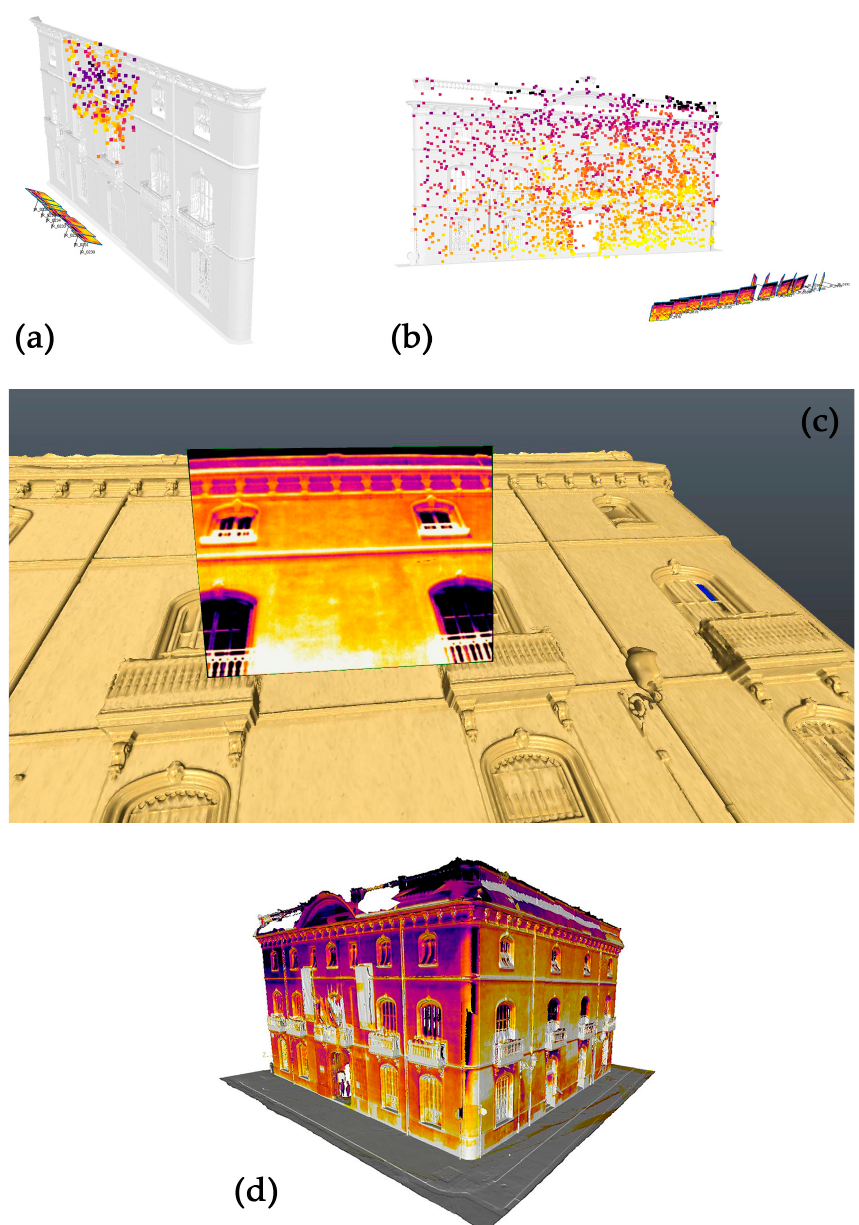
Figure 7. ( a ) Oriented block of thermal images following an SfM-based pipeline (upper area of the central modules of the northern façade; ( b ) oriented block of thermal images following an SfM-based pipeline (southern façade); ( c ) example of oriented TIR image projected of the three-dimensional surface; ( d ) 3D mesh after the first phase of the